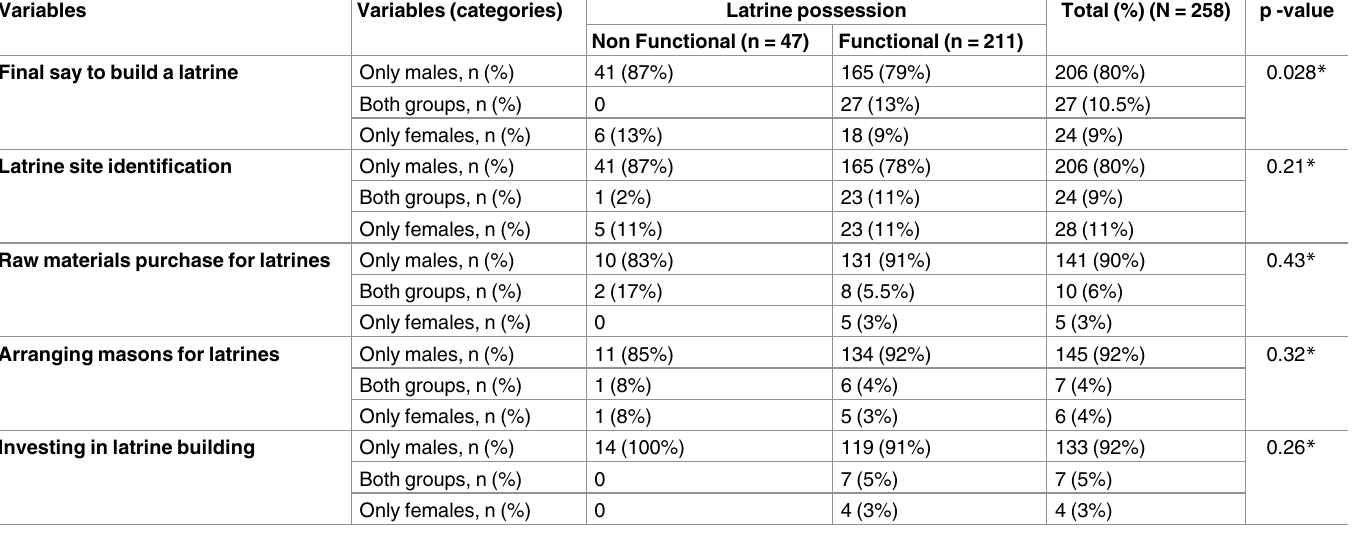
Table 4. Women’s involvement in decision making around stages of latrine building(N =